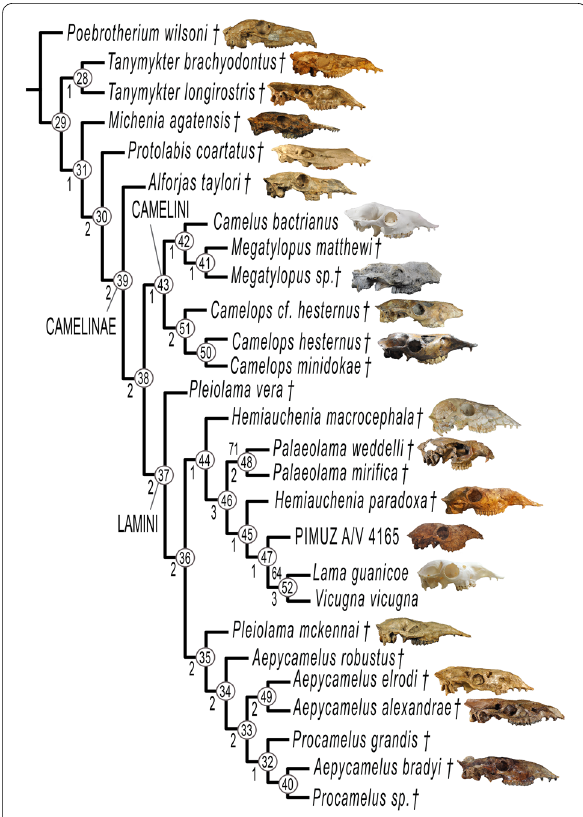
Fig. 12 Most parsimonious tree (TL 149 steps, CI 0.423, = = RI 0.675, RC 0.286). Numbers in circles indicate node numbers. = = Numbers below branches indicate Bremer supports. Only clade 48 and clade 52 have a Bootstrap value over 50%, respectively, at 71% and 64% (see Additional file 2, for information on the skulls, pictures not to